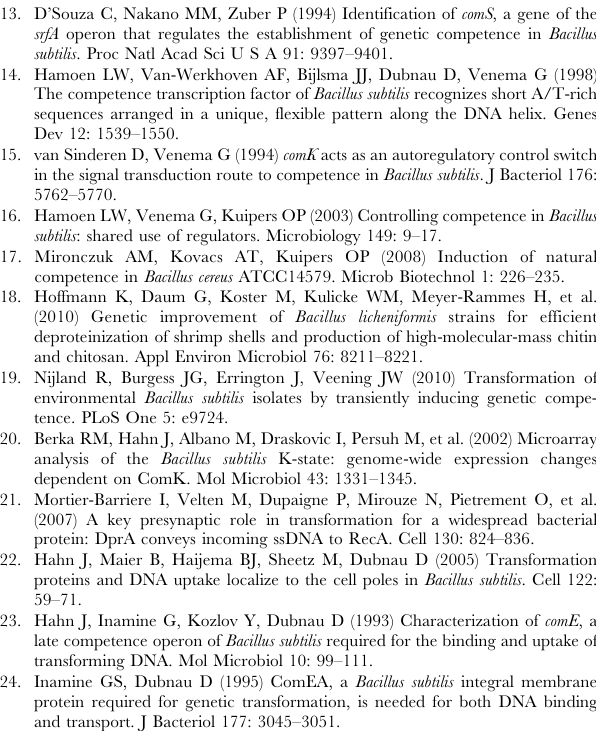
Table S3 Summary of transcriptional changes in